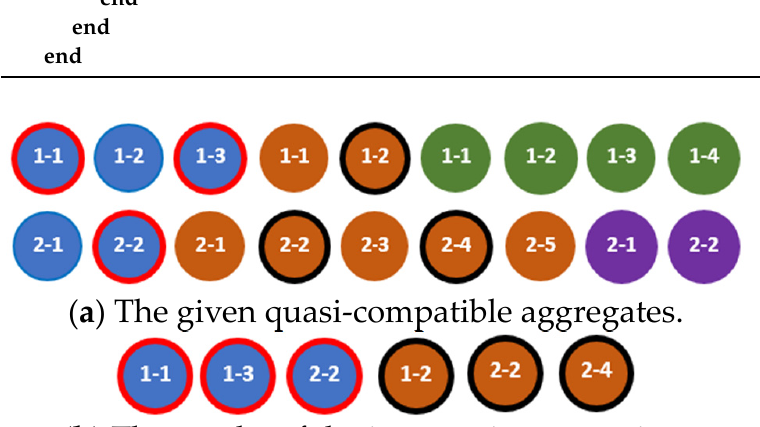
( b ) The results of the intersection operation. Figure 6. An example of applying the intersection operation to two compatible aggregates.